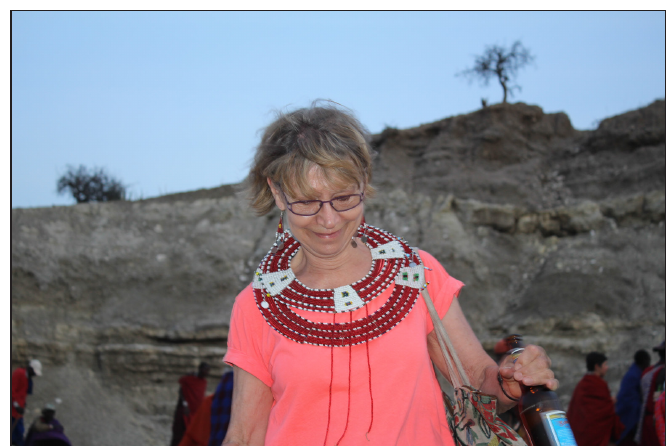
Figure 6: Norah Moloney at Olduvai Gorge, Tanzania, in 2015 (Photo: Renata